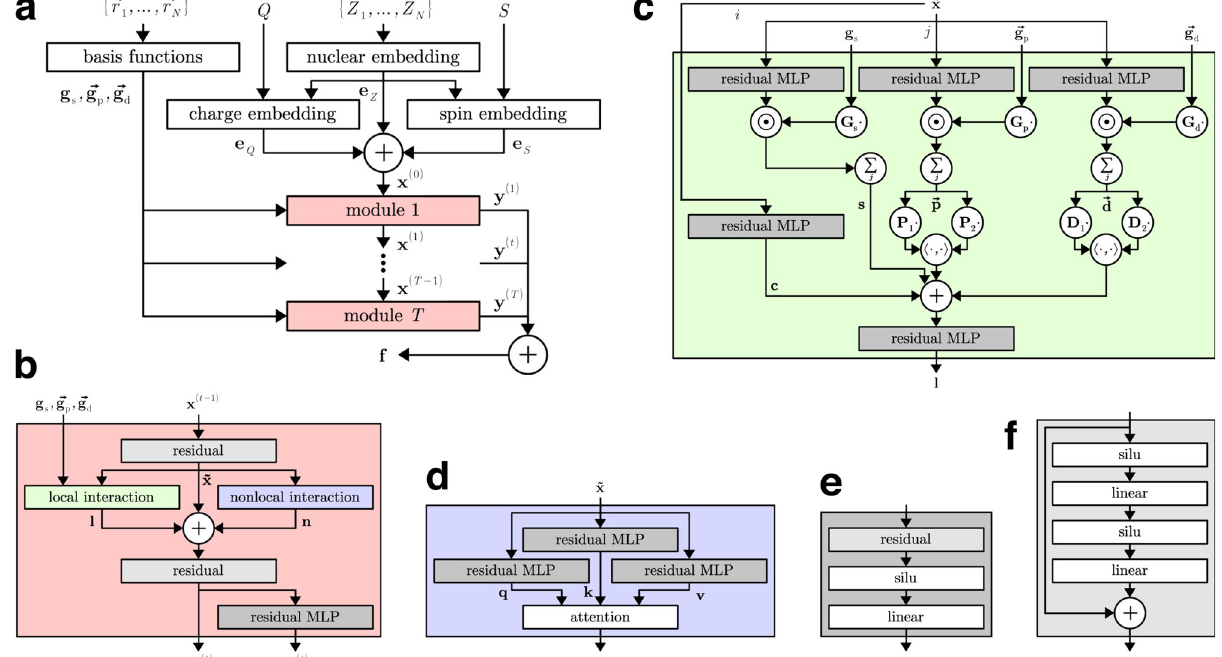
Fig. 3 Schematic depiction of the SpookyNet architecture with color-coded view of individual components. a Architecture overview, for details on the nuclear and electronic (charge/spin) embeddings and basis functions, refer to Eqs. (9), (10), and (13), respectively. b Interaction module, see Eq. (11). c Local interaction block, see Eq. (12). d Nonlocal interaction block, see Eq. (18). e Residual multilayer perceptron (MLP), see Eq. (8). f Pre-activation residual block, see Eq.